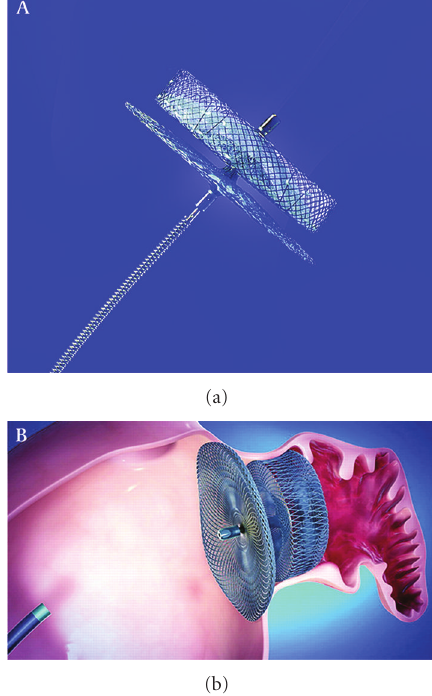
Figure 2: The AMPLATZER Cardiac Plug shown (a) mounted on its delivery catheter and (b) properly deployed at the ostium of the left atrial appendage. ( Image courtesy of BMJ Publishing Group Ltd and British Cardiovascular Society.